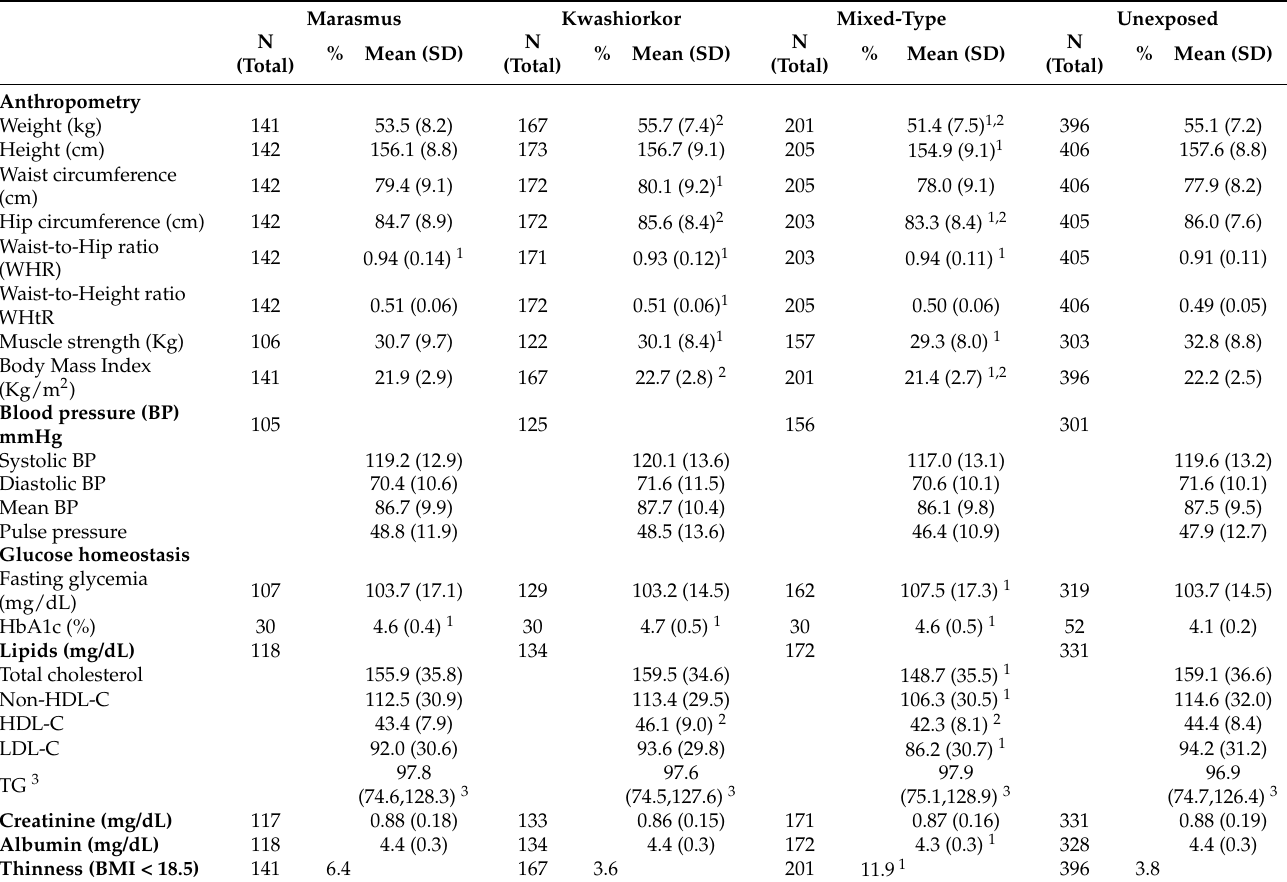
Table 4. Unadjusted differences in clinical and biological cardiometabolic markers of NCDs in the three SAM subgroups and unexposed